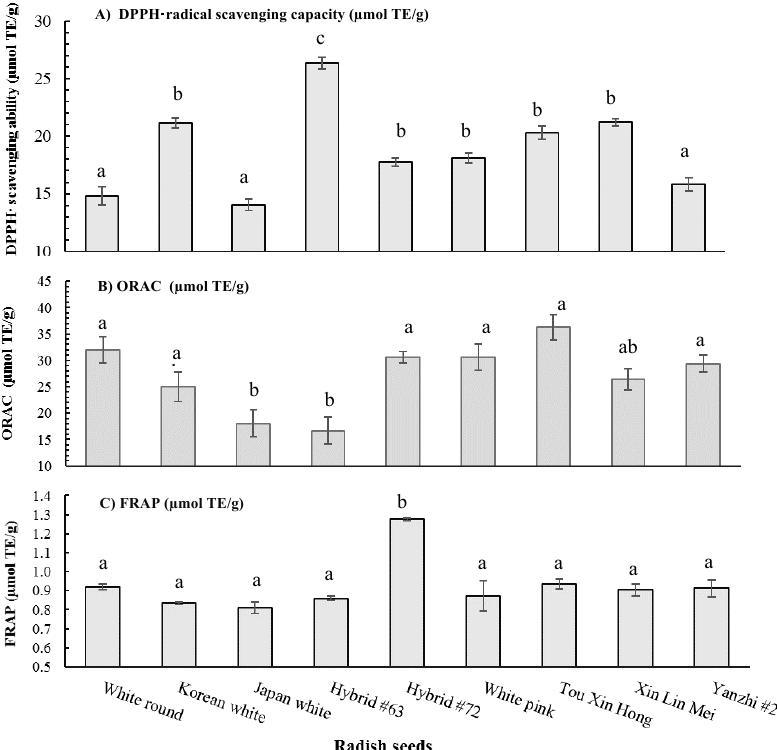
Fig. 1: Antioxidant activities of radish seeds: A) DPPH· radical scavenging capacity values; B) ORAC values; C) FRAP. Results expressed as μmol Trolox equivalents (TE)/g RSF. Tests were conducted in triplicate. Vertical lines represent standard deviations. Columns marked with different letters are significantly different